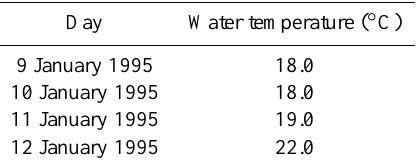
Table 2. Temperature of the water ( ◦ C), which was pumping by the cooling system of Companhia Nacional de ´Alcalis (situated in Cabo Frio region) in days 9–12 January